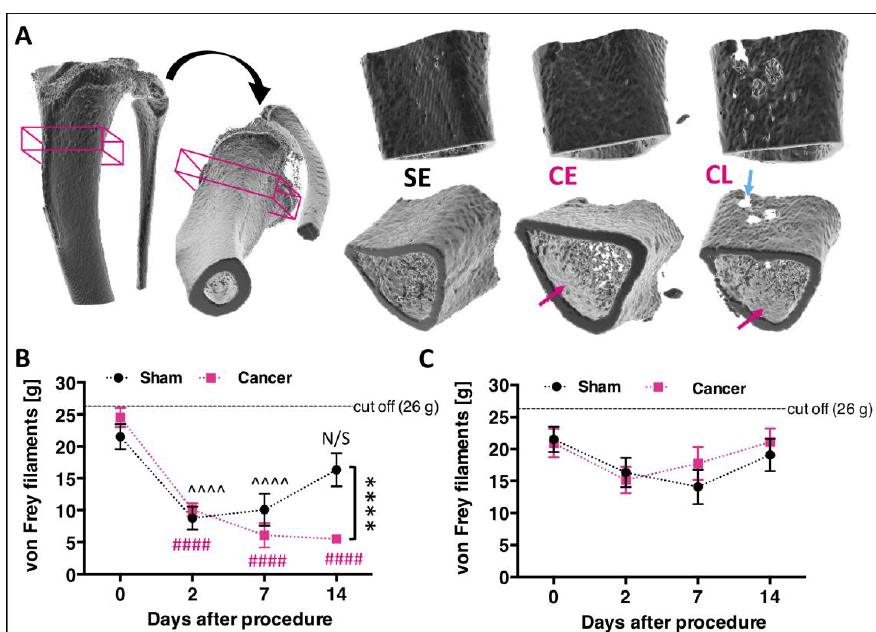
Figure 1. Progressive cancer-evoked bone destruction is reflected in the development of mechanical allodynia. ( A ) Example of microcomputer tomography 3D-rendered rat tibia with corresponding orthogonal projections. The boxed area represents the centre of the cancer-growth zone and constitutes of 114 z-scans taken every 34 µ m. Example of the reconstructed cancer growth zone in sham early (SE), cancer early (CE, day 7/8), and cancer late (CL, day 14/15) stages are shown. Blue arrow points at cortical bone lesion, and red arrows point at trabecular bone lesions. See Movie S1 for 360 ◦ view. ( B ) von Frey filament-tested mechanical hypersensitivity progression following cancer cells implantation substantially differing from sham-operated control by the late cancer stage (two-way ANOVA with Bonferroni post-hoc: ^^^^ sham, #### cancer vs. day 0, p < 0.0001. Day 14 sham vs. cancer: **** p < 0.0001, n = 12 per group). ( C ) No changes in mechanical sensitivity were observed on the contralateral paw during the whole course of the experiment (two-way repeated-measures (RM) ANOVA with